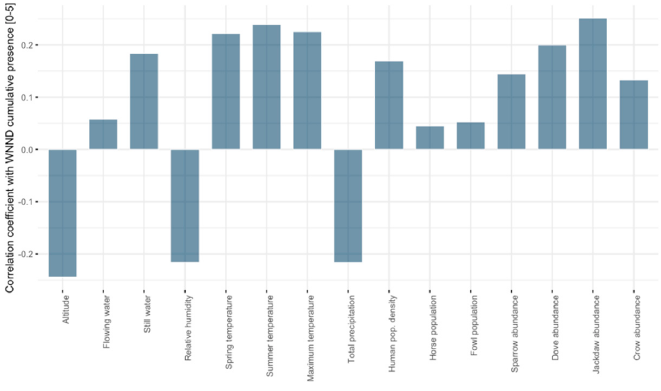
Figure 6. Spearman’s rank correlation coefficient between the cumulative presence 2015–2019 [0–5] and the predictors.